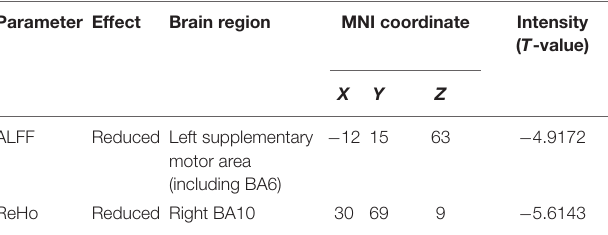
TABLE 4 | Regions of DH showing significant changes in ALFF and ReHo values compared with